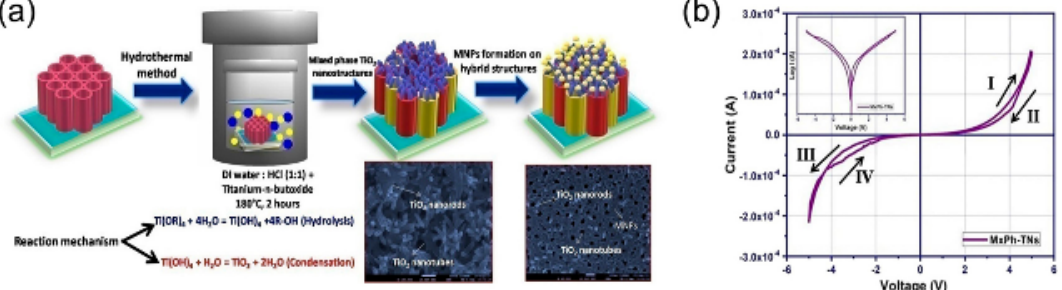
Figure 11. ( a ) MxPh − TNs and MX − TNHs coated with MNPs by the photo deposition process. ( b ) I − V hysteresis return line of Al/MxPh − TNs/Ti. Reproduced with permission from Ref. [77]; pub- lished by the American Chemical Society, 2020.